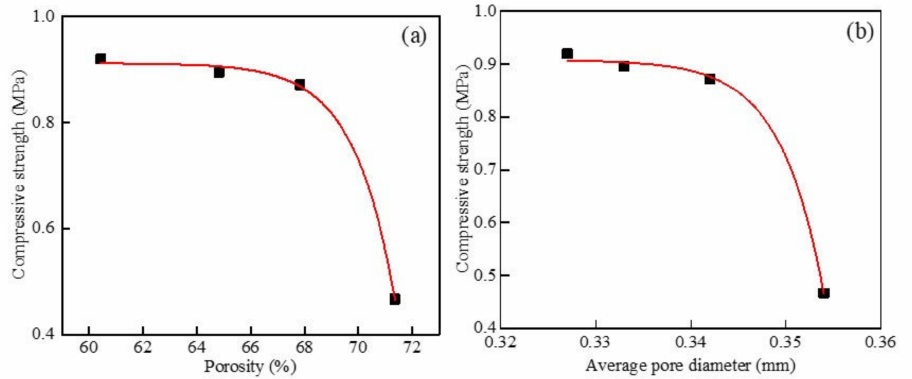
Figure 15. Compressive strength versus porosity ( a ) and average pore size ( b ) of the recycled foamed concrete containing MSWI powder with different w/c